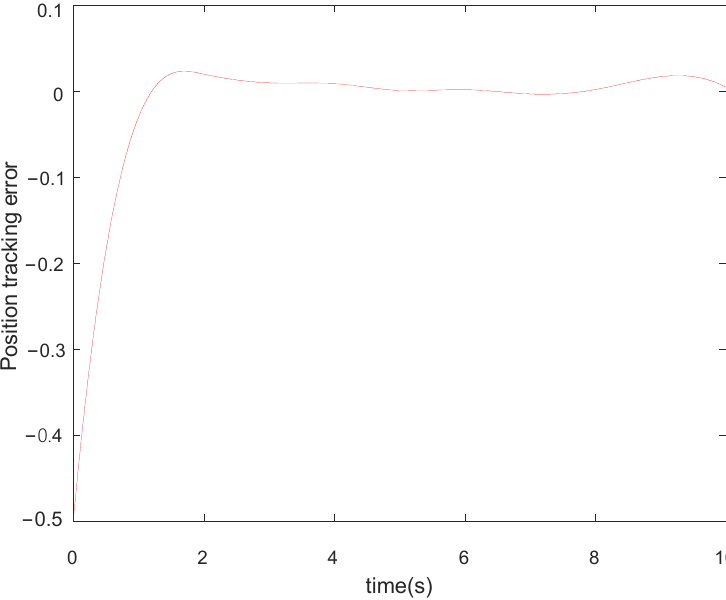
Figure 4. Position tracking error curves without error compensation.